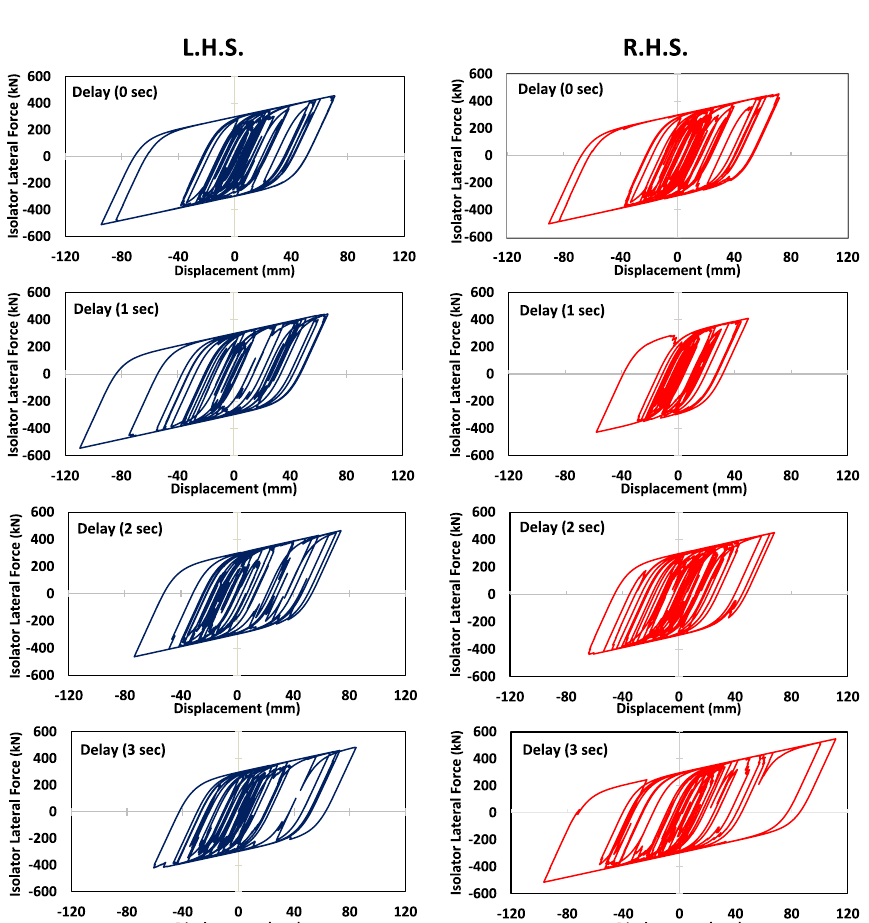
Fig. 19 Force‑displacement loop of base isolator under Imperial Valley